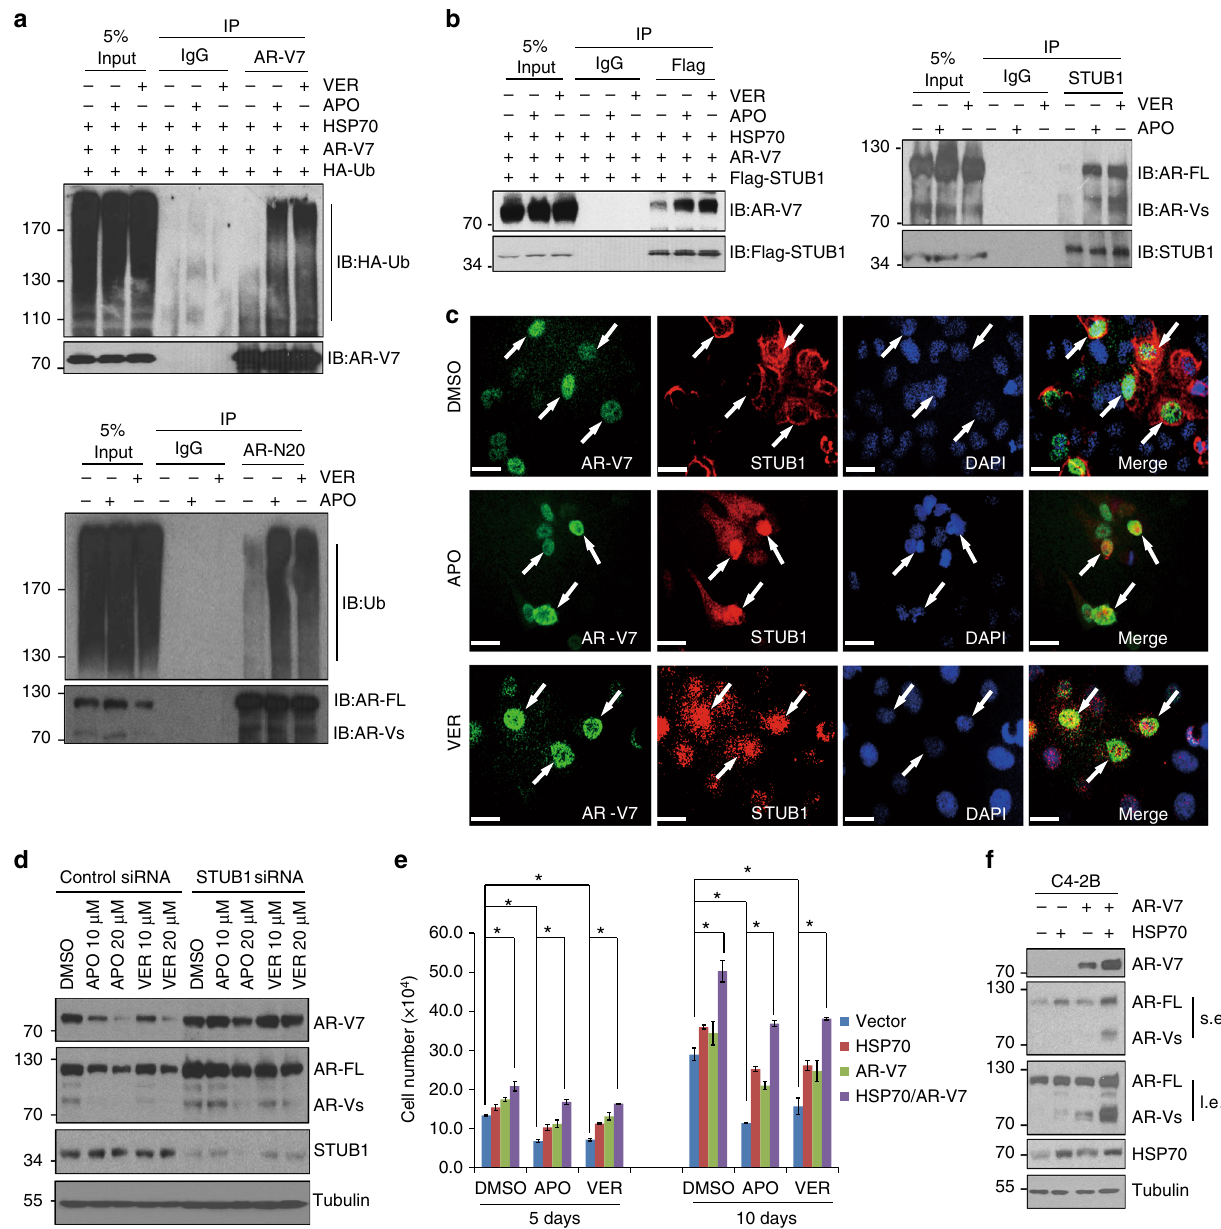
Fig. 4 HSP70 inhibitors promote AR-V7 ubiquitination via STUB1. a Immunoblots following anti-AR-V7 immunoprecipitation from AR-V7, HSP70, and HA- Ubiquitin overexpressed 293 cells that were co-treated overnight with 20 μ M APO or VER with 5 μ M MG132 to inhibit degradation of ubiquitinated AR-V7 (top). C4-2B MDVR cells were treated with 20 μ M APO or VER overnight with 5 μ M MG132 for 6 h, total cell lysates were immunoprecipitated with anti- AR (N20) antibody and immunoblotted with anti-ubiquitin and AR-FL antibodies (bottom). b AR-V7, HSP70, and Flag-STUB1 were overexpressed in 293 cells and then treated with APO or VER overnight. Whole cell lysates were subjected to anti-Flag IP, AR-V7, and Flag were blot (left). C4-2B MDVR cells were treated with 20 μ M APO or VER overnight with 5 μ M MG132 for 6 h, total cell lysates were immunoprecipitated with anti-STUB1 antibody and immunoblotted with anti-AR, STUB1 antibodies (right). c 293 cells were co-transfected with AR-V7, HSP70, and Flag-STUB1 for 3 days, following treatment with APO or VER for 24 h, AR-V7 and STUB1 were visualized by dual immuno fl uorescence staining. White arrows indicated the typical staining cells in each group. Scale bar 20 µ m. d C4-2B MDVR cells were transiently transfected with STUB1 siRNA for 3 days, following treatment with APO or VER overnight; whole cell lysates were collected and subjected to western blot. e , f C4-2B cells were transiently transfected with vector, AR-V7, HSP70, or AR-V7 plus HSP70, following treatment with APO or VER, the cell growth was determined at 5 and 10 days. The whole cell lysates were collected and subjected to western blot. * p < 0.05. Results are the mean of three independent experiments (±s.d.). Statistical analysis was performed using one- way ANOVA. AR-FL: full-length AR, AR-Vs: AR-Variants, Ub: Ubiquitin, APO: Apoptozole, VER: Ver155008, s.e.: short exposure, l.e.: long suppressed tumor PSA expression ( p = 0.28), APO treatment compared to either vehicle or enzalutamide treatment alone signi fi cantly suppressed PSA ( p = 0.029), and the combination (Fig. 6j). Immunohistochemical staining of Ki67 showed cell treatment further reduced the PSA levels ( p = 0.0053) (Fig. 6i). proliferation was signi fi cantly inhibited by APO, and further APO and the combination treatments also improved survival inhibited by the combination treatment (Fig. 6k). Taken together,